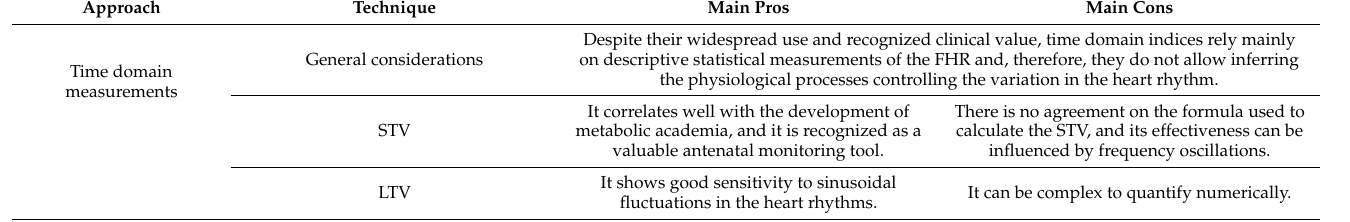
Table 2. Main pros and cons of the most used techniques for the analysis of